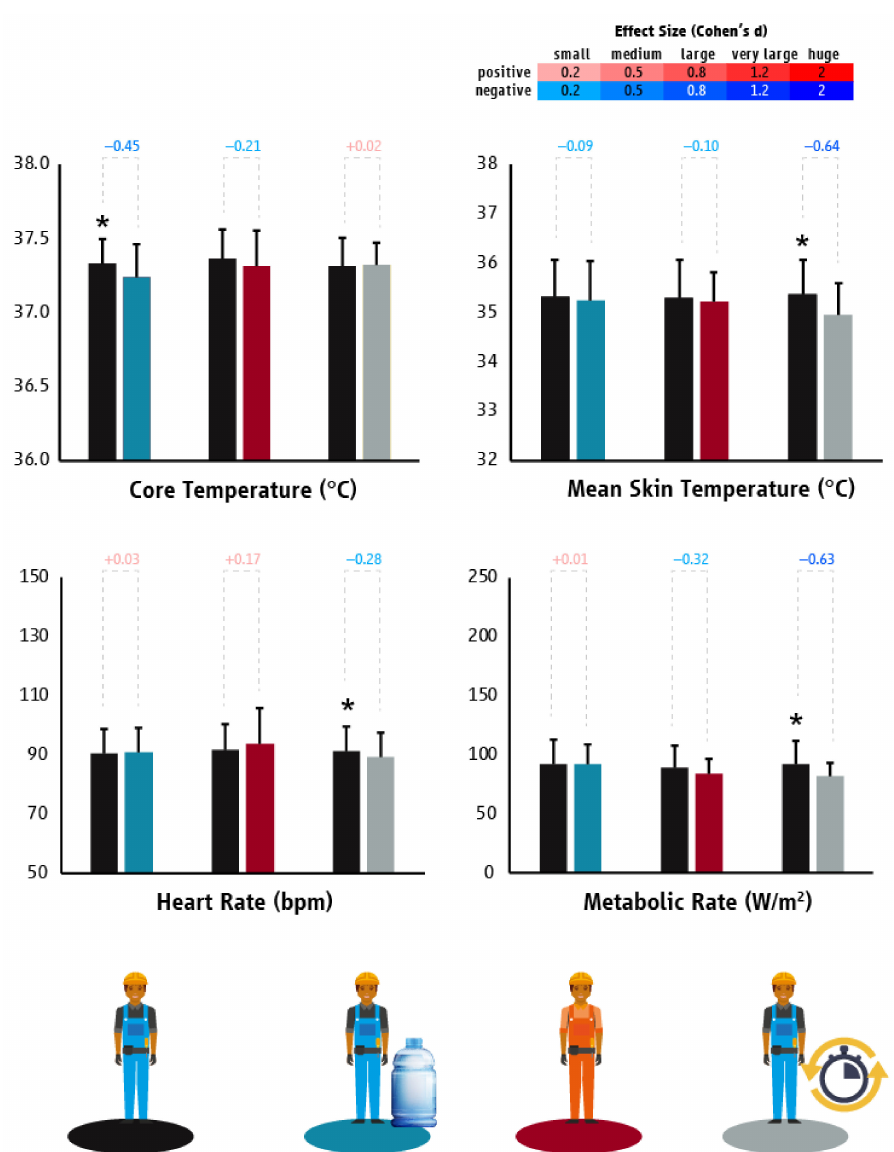
Figure 7. Differences (mean ± SD) in core temperature, mean skin temperature, heart rate, and metabolic rate/work intensity between “business as usual” and the tested heat mitigation strategies in the construction sector of Qatar. Black, light blue, red, and grey colors represent “business as usual”, hydration, evaporative garments, and planned breaks scenarios, respectively. Asterisks indicate statistically significant differences between “business as usual” and the tested heat mitigation strategies. Cohen’s d effect sizes show the magnitude (small: 0.2; medium: 0.5; large: 0.8; very large: 1.2; huge: 2.0) and direction (positive: shades of red; negative: shades of blue) of the differences between “business as usual” and the tested heat mitigation